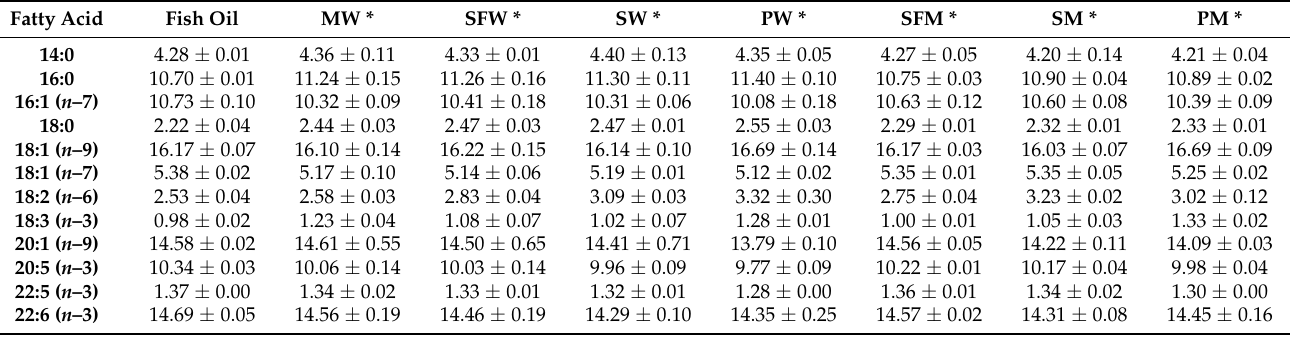
Table 2. Fatty acid composition (% of total fatty acids) of non-encapsulated and encapsulated fish oil, including sums of saturated fatty acids ( Σ SFA), monounsaturated fatty acids ( Σ MUFA), polyunsaturated fatty acids ( Σ PUFA), and n– 3 and n– 6 fatty